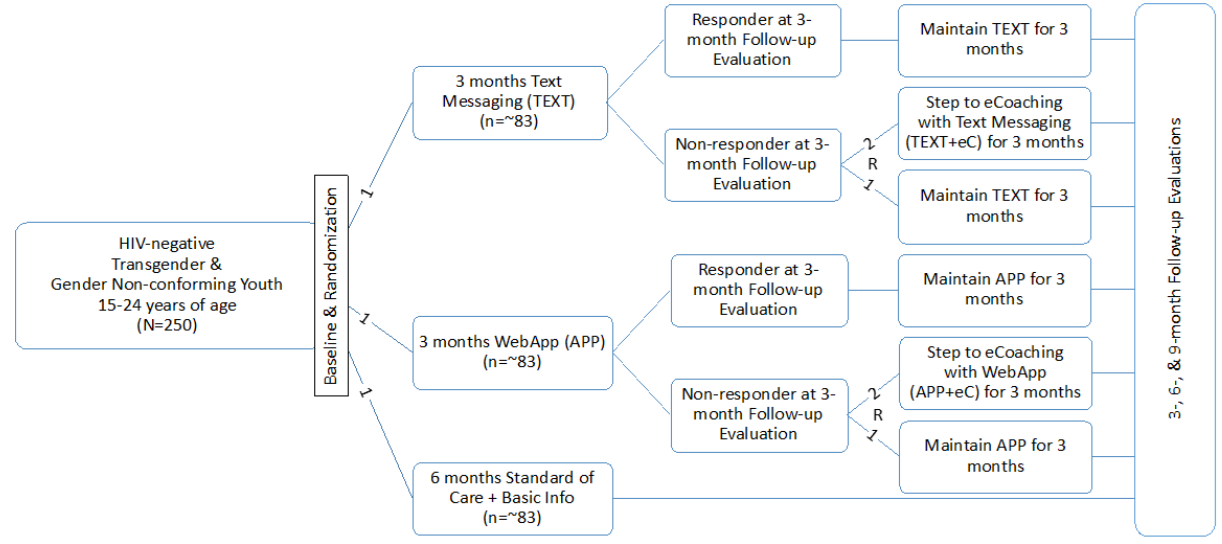
Figure 2. TechStep study design. eCoaching: electronic